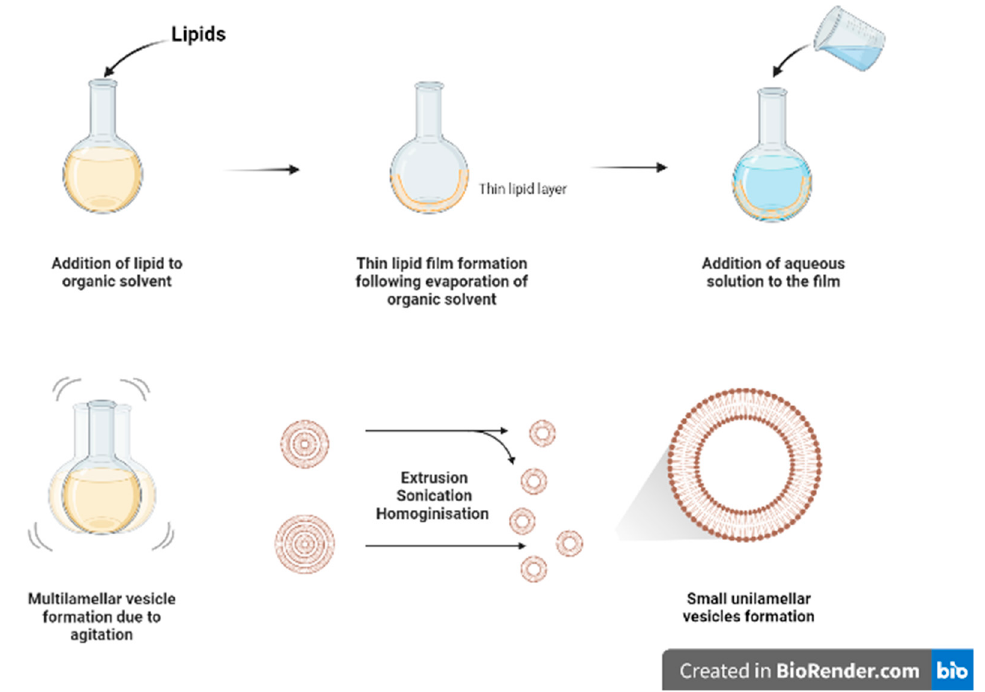
Figure 2. Schematic diagram of thin film hydration method.